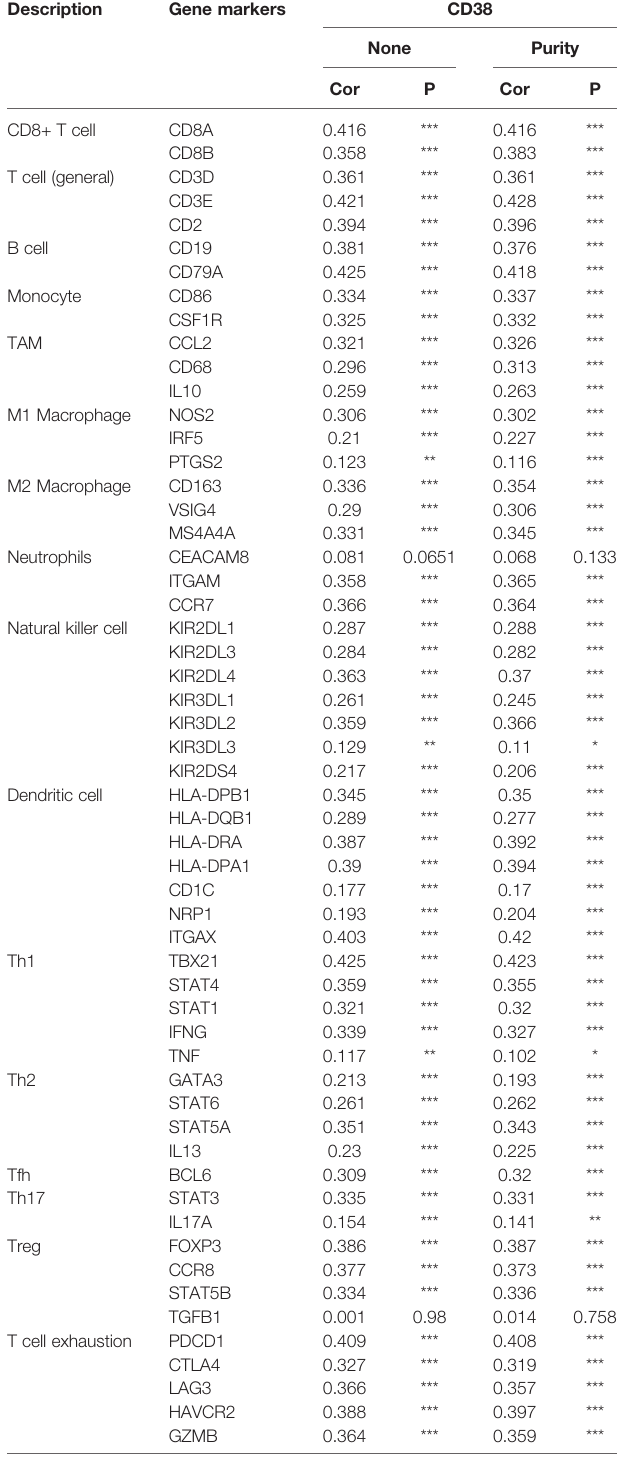
TIMER, Tumor Immune Estimation Resource; TAM, tumor-associated macrophage; Th, T helper cell; Tfh, follicular helper T cell; Treg, regulatory T cell; Cor, R value of Spearman ’ s correlation; None, correlation without adjustment. Purity, correlation adjusted by purity. *,**,*** represented that differences were considered statistically signi fi cant with P < 0.05, P < 0.01 P < 0.001